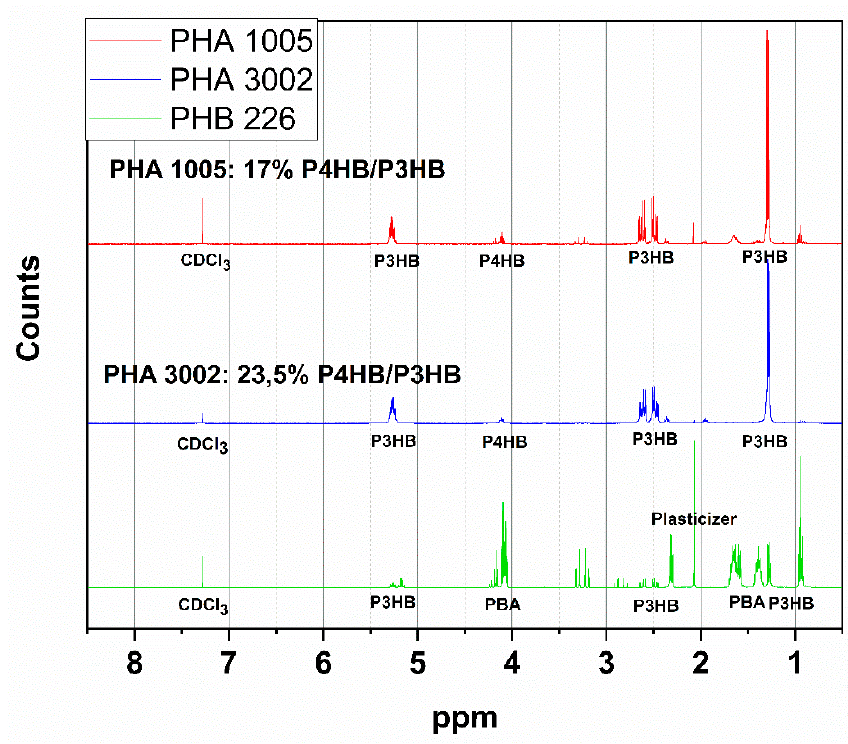
Figure 1. The 1 H-NMR spectra of PHB226, PHA1005 and PHA3002.